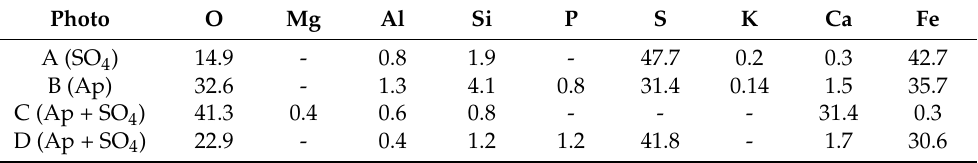
Table 5. Composition of mineral phases in microphotographs. Instrumental error 0.05